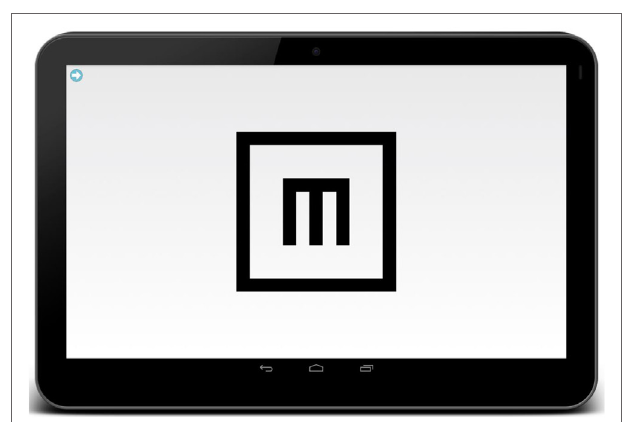
FigUrE 1 | Tumbling E Near Acuity Test, adapted from the android-based distance optotype test, “peek acuity lite” (14.5). The patient is asked to swipe in the direction of the limbs of the E and a staircasing algorithm detects the threshold acuity